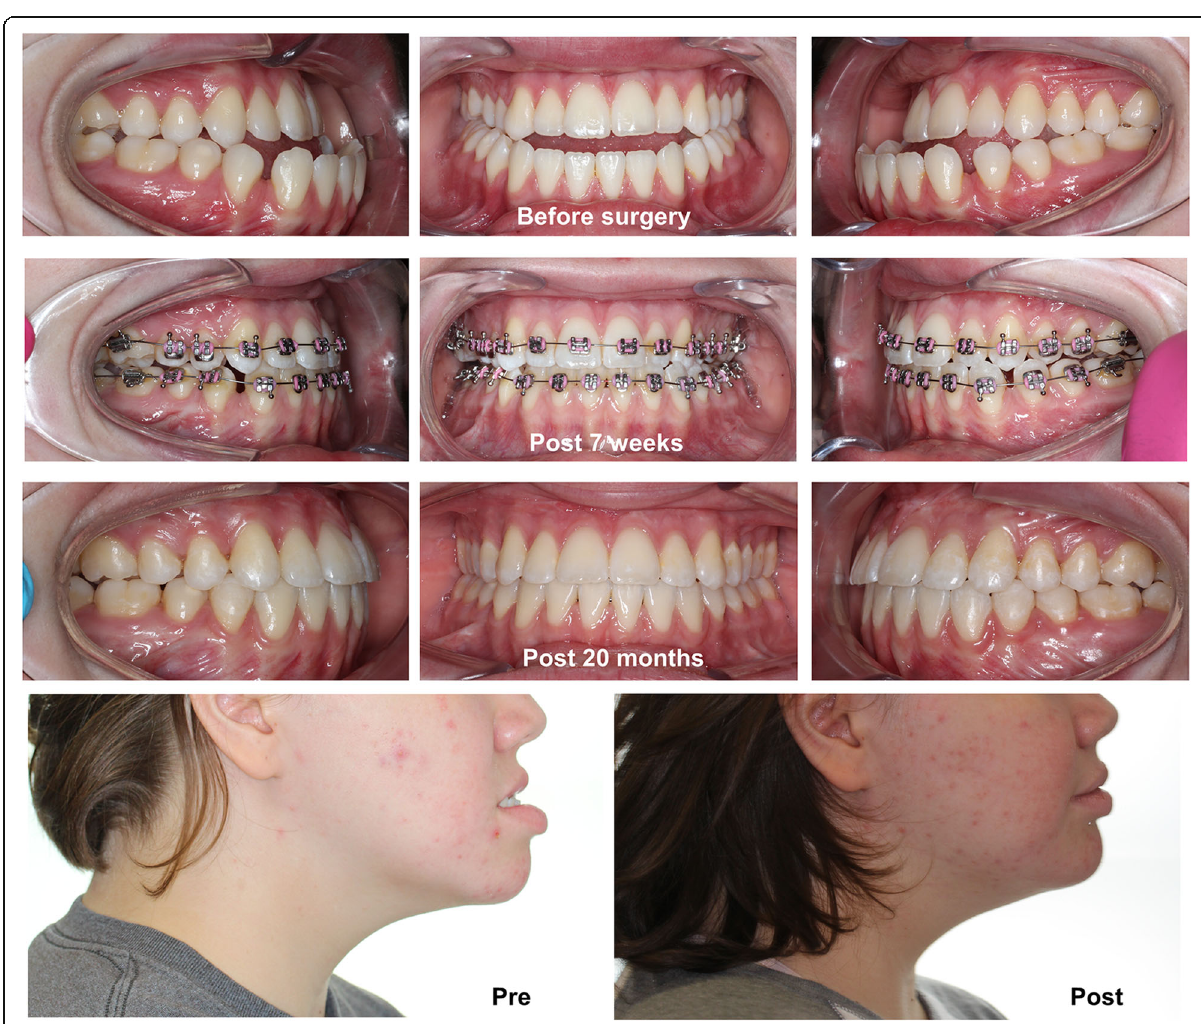
Fig. 1 A case with surgery first approach (SFA). An 18-year-old female patient had been successfully treated by two jaw surgery followed by the 20 months of postsurgical